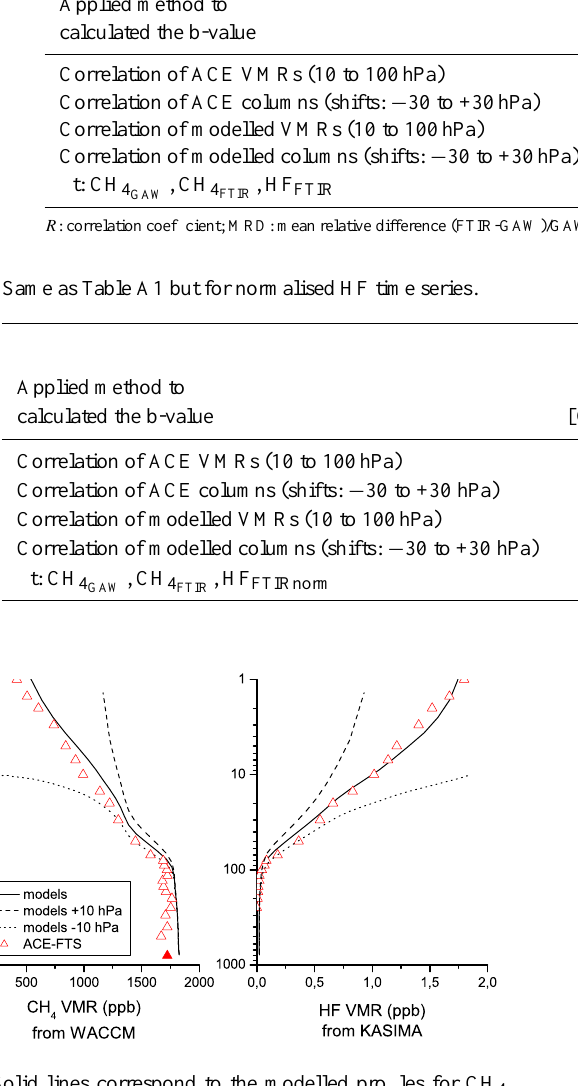
calculated from CH 4 post